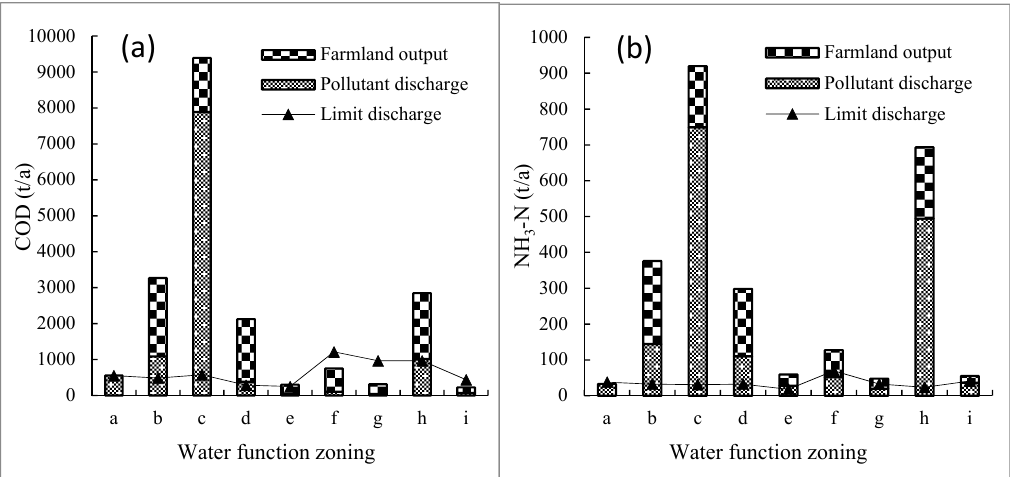
Figure 9. Total output of pollutants and sewage discharge limit of water function zones. ( a ) Chemical oxygen demand; ( b ) ammonia nitrogen.